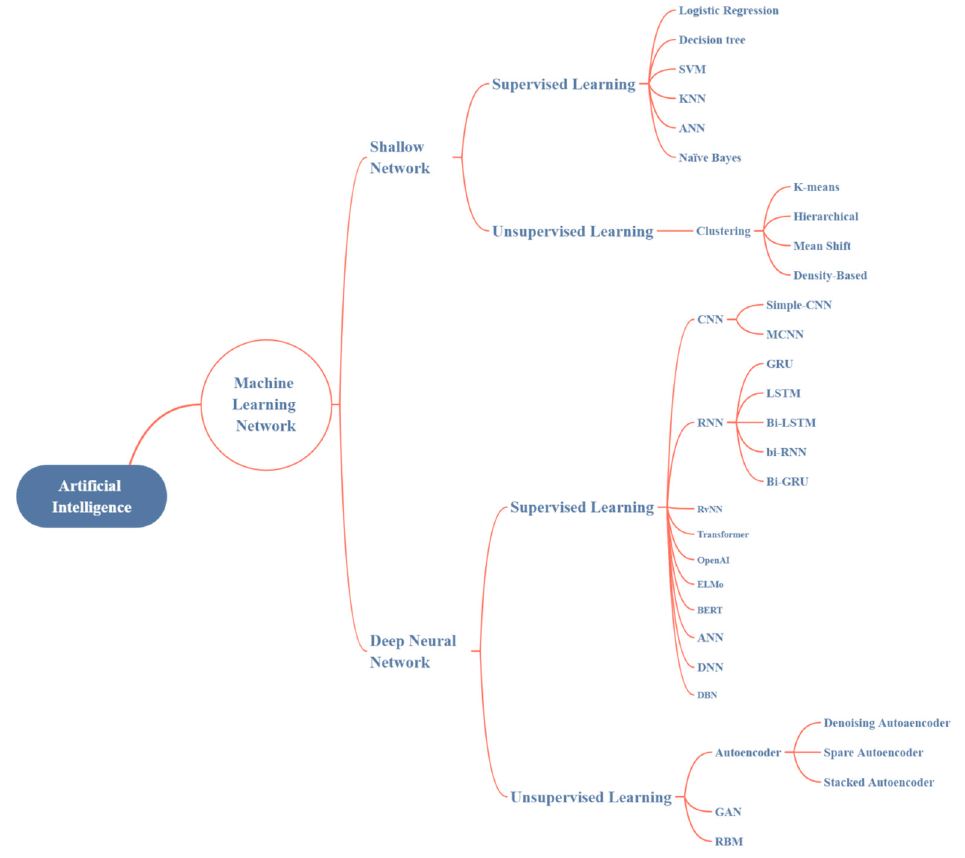
Figure 2. Taxonomy of most commonly used machine learning network for causality mining.